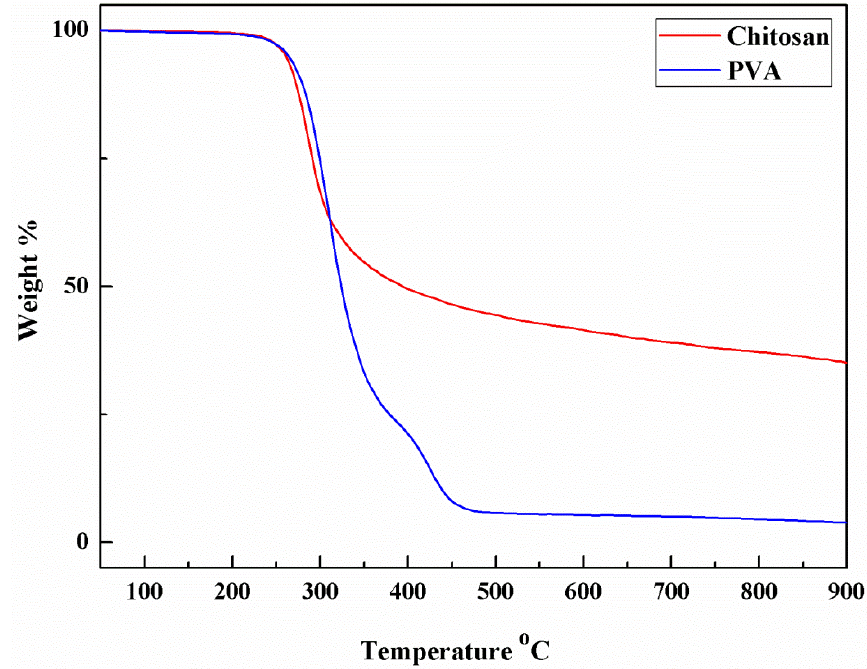
Figure 3. TGA curves of chitosan and PVA.